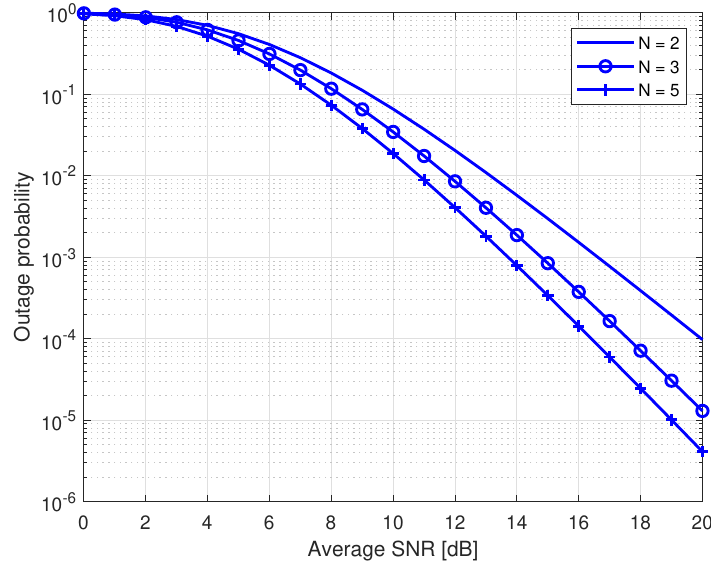
Figure 4. Outage probability versus signal to noise ratio (SNR) for EH relaying.